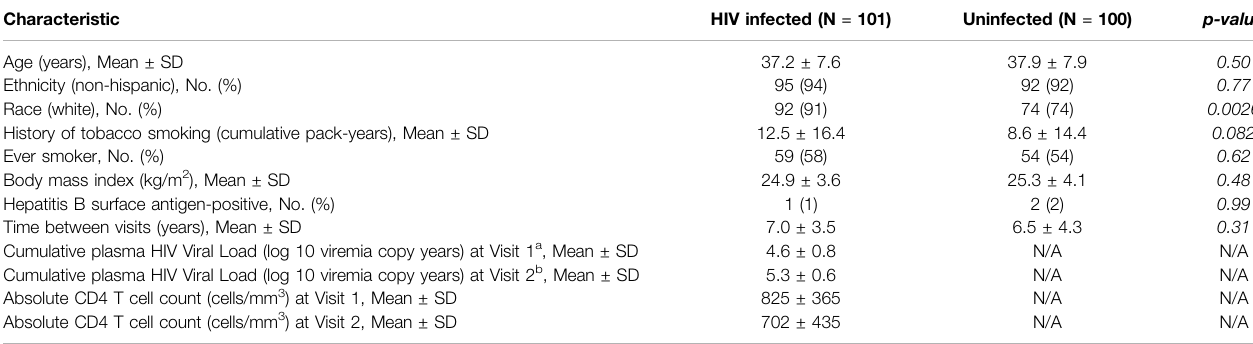
TABLE 1 | Baseline characteristics of study participants.